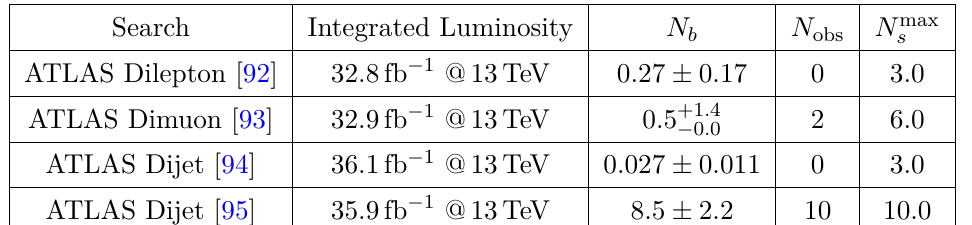
Table 7 . 95% probability bounds on the number of signal events, N max